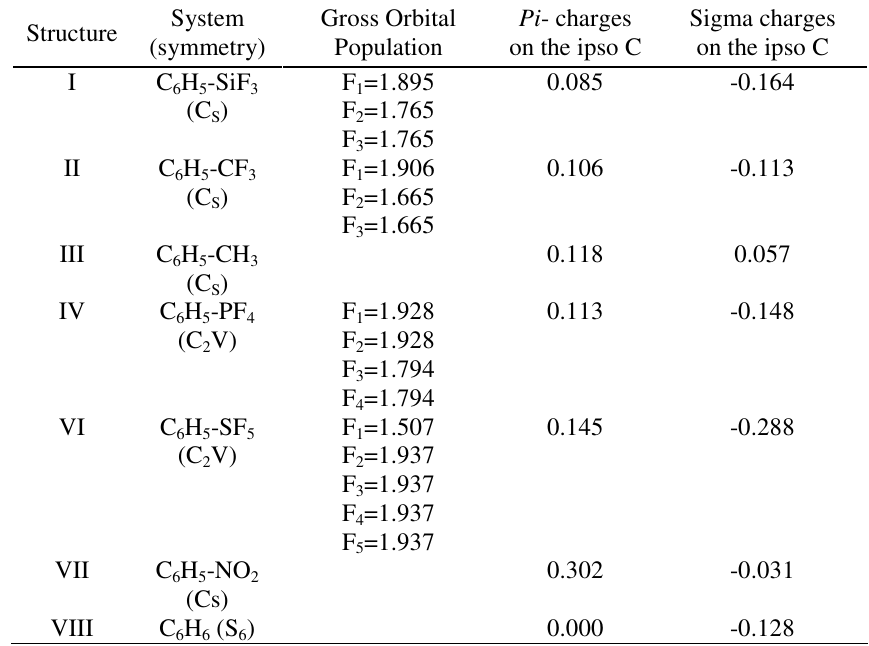
Table 2. The Gross orbital population number ( pi orbital electron number) of the different systems obtained by DFT 6-31 G* MO calculations at the B3LYP level and the pi charges at the ipso carbon